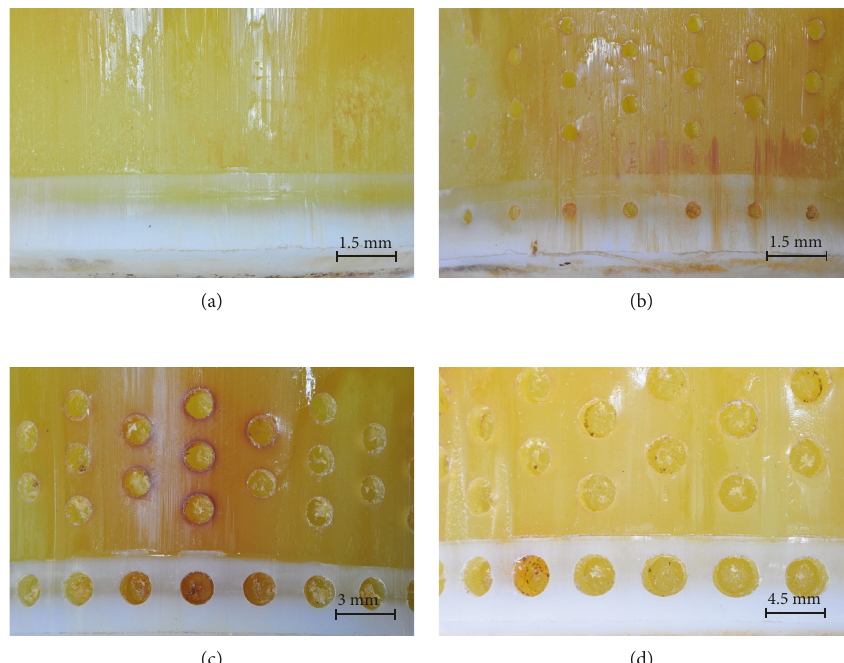
Figure 7: Wear patterns of the piston leather cup under the same wear time: (a) L-Standard piston, (b) T1 piston, (c) T2 piston, and (d) T3 piston. Table 4: Grid nodes and elements. Piston no.